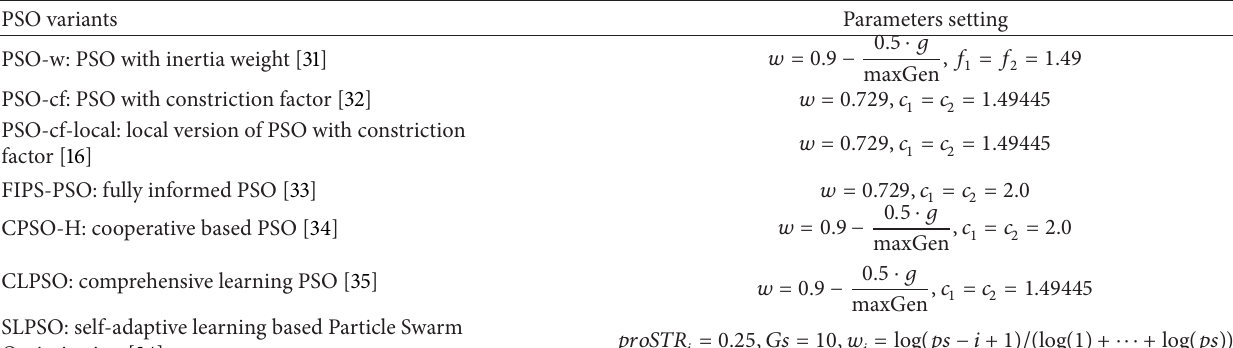
Table 1: PSO variants used in comparative